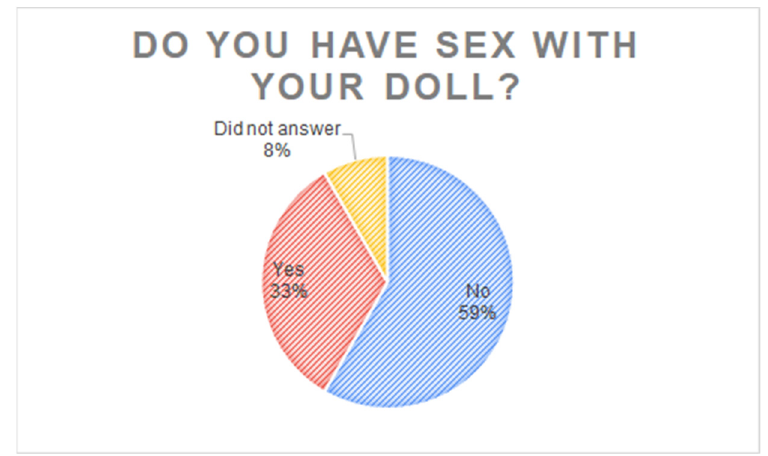
Figure 1. Responses on whether the doll owners had sexual relations with their dolls (Source: Prepared by the authors).